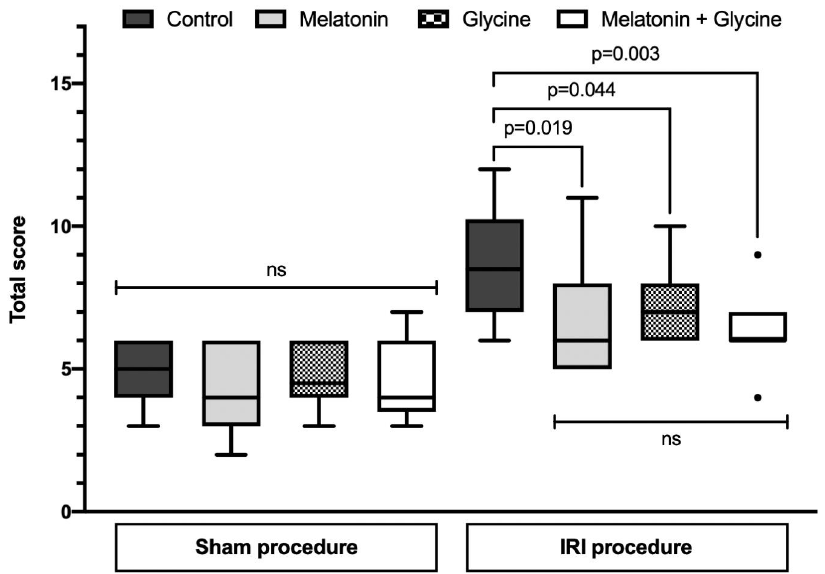
Figure 2. Total score of uterus histological evaluation for IRI. IRI: ischemia/reperfusion injury. Data presented as median and interquartile range ( n = 10/group, except n = 9 in sham combined treatment group). Table 1. Results of the scoring system for uterus IRI